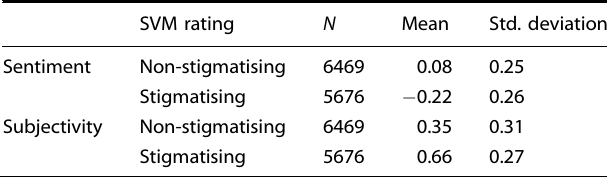
Table 1. Sentiment and subjectivity scores for tweets identi fi ed as either stigmatising or not stigmatising by the Support Vector